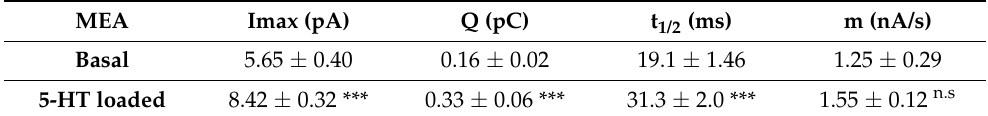
Table 1. Kinetic parameters of amperometric spikes obtained with diamond MEAs. Data from 10 human subjects. Calculations were performed on the N basis (average was found by taking all spikes from each subject and the results were used for statistics). We used the same spikes shown in Figure 3C; Means ± SEM. *** p < 0.005: n.s: not significant. Student’s t test. MEA Imax (pA) Q (pC) t 1/2 (ms) m (nA/s) Basal 5.65 ± 0.40 5-HT